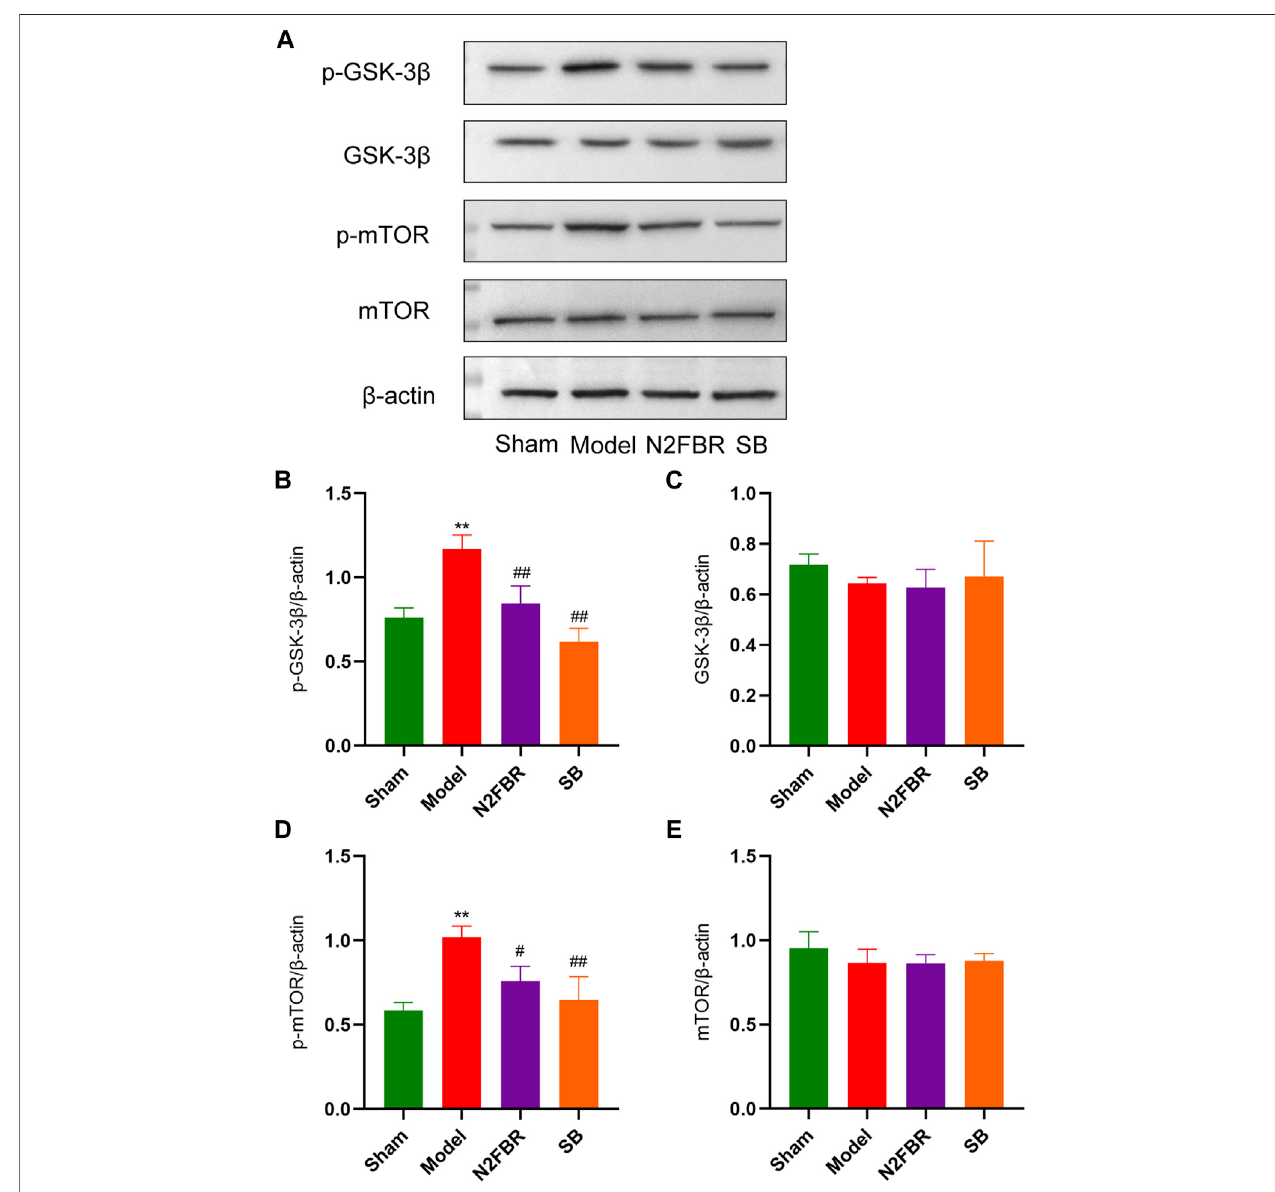
FIGURE 7 | N2FBR activated the GSK-3 β /mTOR signaling pathway. (A) Protein levels of p-GSK-3 β , GSK-3 β , p-mTOR, and mTOR as quanti fi ed by western blotting. Relative density values showing (B) p-GSK-3 β , (C) GSK-3 β , (D) p-mTOR and (E) mTOR expression. Data are expressed as ** p < 0.01, compared with sham group; # p < 0.05, ## p < 0.01, compared with model